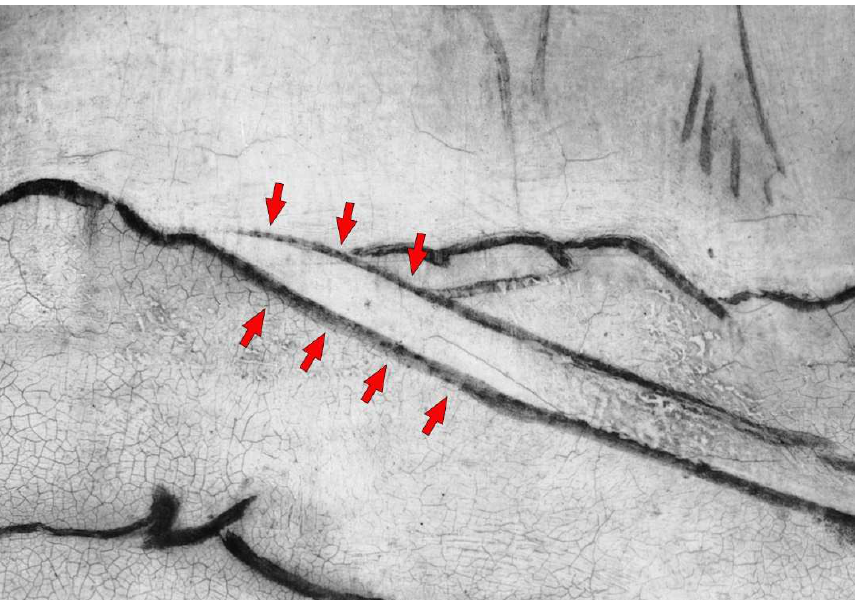
Figure 12. HR-SWIR detail showing the traces of punched dots, indicated by the red arrow, in correspondence to the neck of the Madonna.